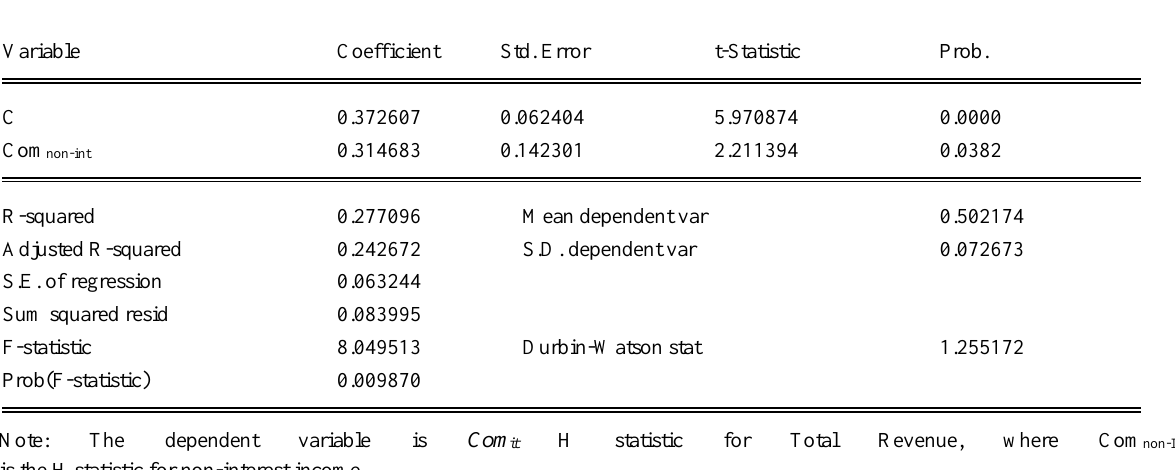
Table 3: Results of the regression analysis Equation